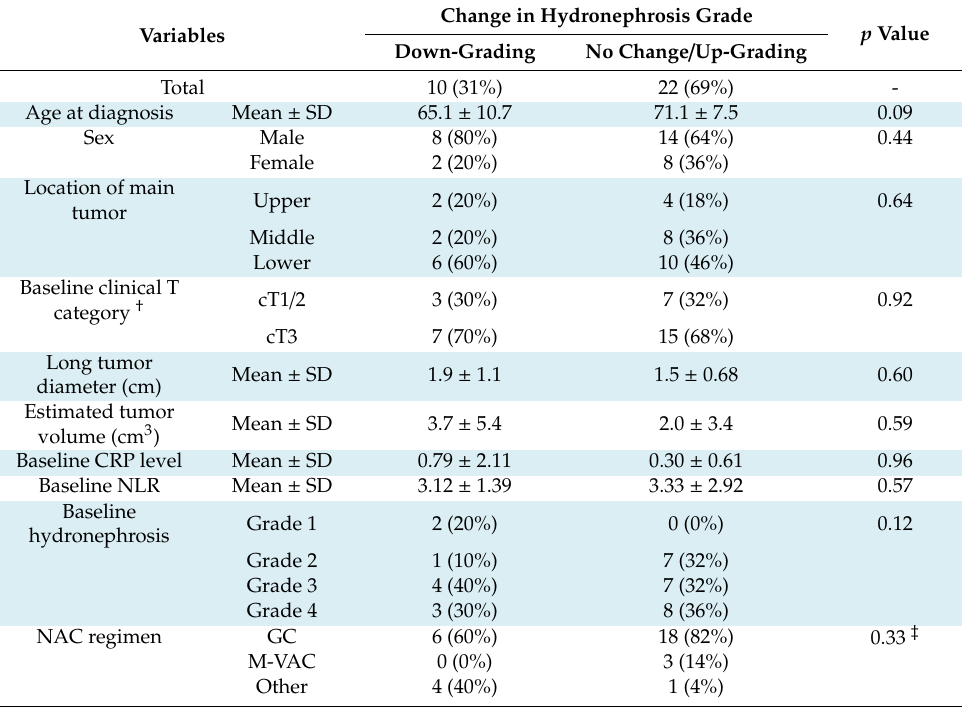
Table 2. Association between the baseline characteristics and change of hydronephrosis grade after neoadjuvant chemotherapy.